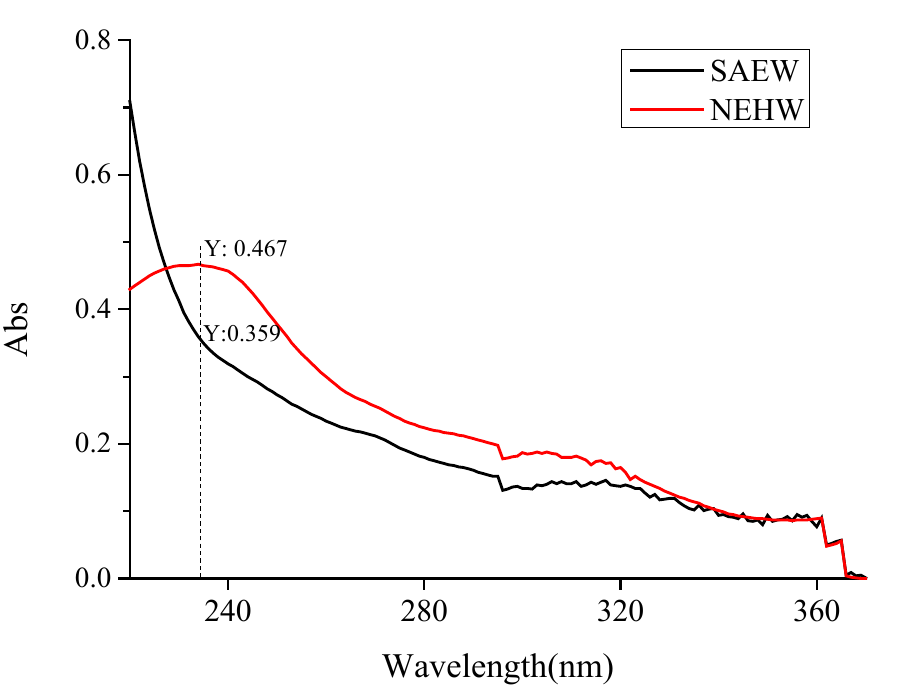
Figure 2. The results of NEHW and SAEW scanning at the wavelength of 220 nm—370 nm on the UV-Vis spectrophotometer. The physical and chemical parameters of NEHW and SAEW are both pH: 5.7; ACC: 30.